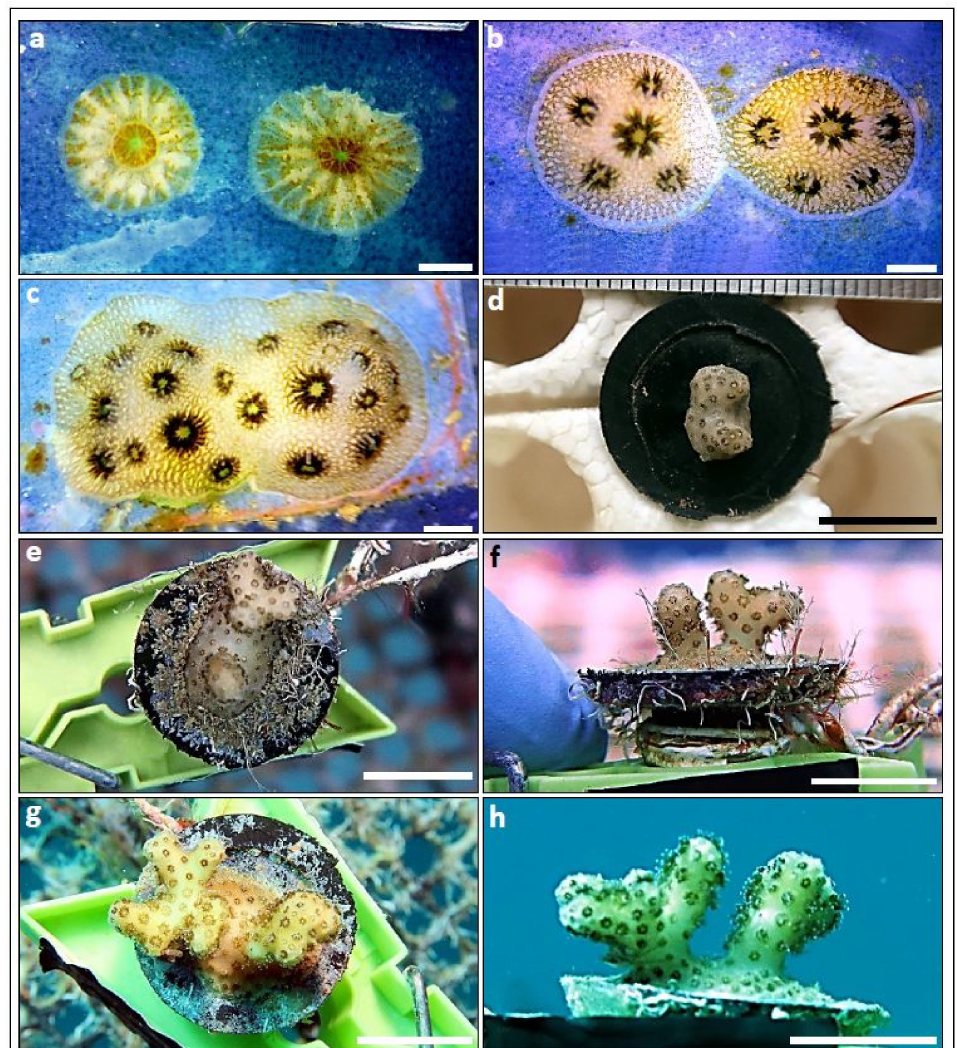
Figure 1. The formation of a bi-chimera colony under laboratory conditions ( a – c ) and the chimera development in the nursery under field conditions ( d – h ). ( a ) 16 days old, two spat; ( b ) 37 days old; at fusion event; ( c ) established chimera, 127 days old; ( d ) 191 days old developing chimeric entity; ( e ) 343 day old; aerial view; ( f ) 343 days old; side view; ( g ) 541 days old; aerial view; ( h ) 541 days old; side